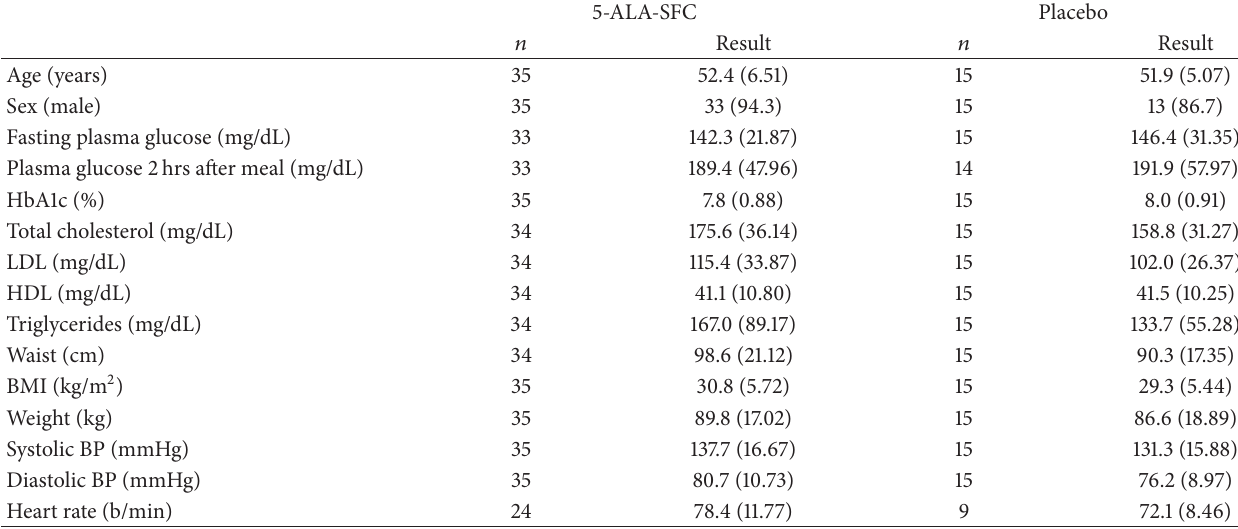
Table 1: Baseline demographics and disease characteristics.